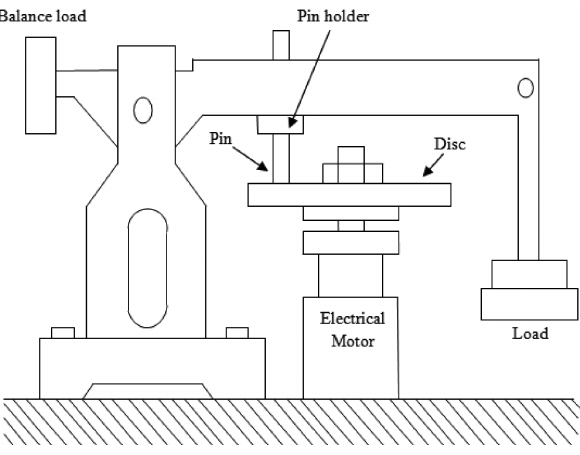
Fig. 2: Schematic display of the pin-on-disk-type standard wear